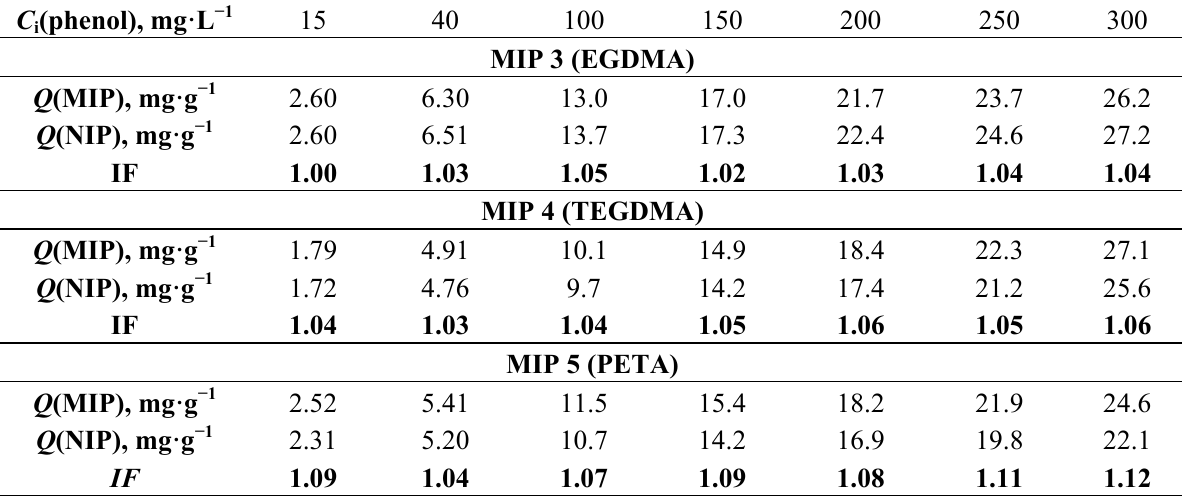
Table S1. Data for binding isotherms for Sty-based MIP/NIP on different cross-linkers for Figure 4.